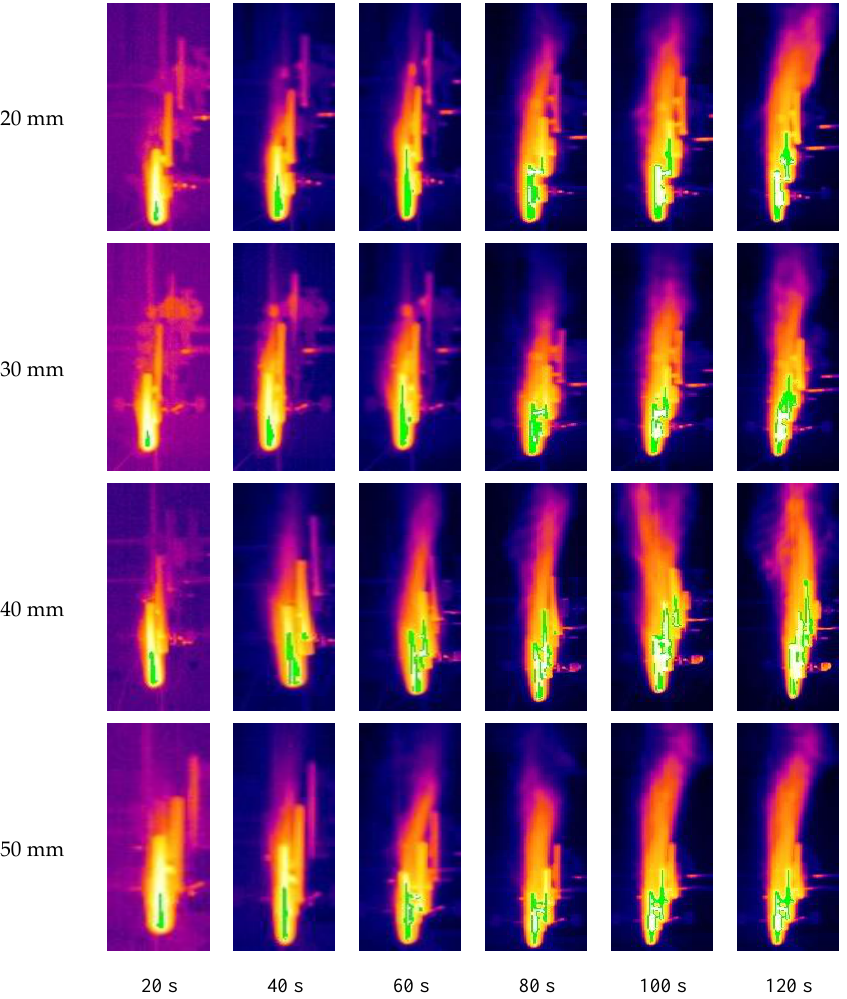
Figure 7. Front view of combustion temperature field.